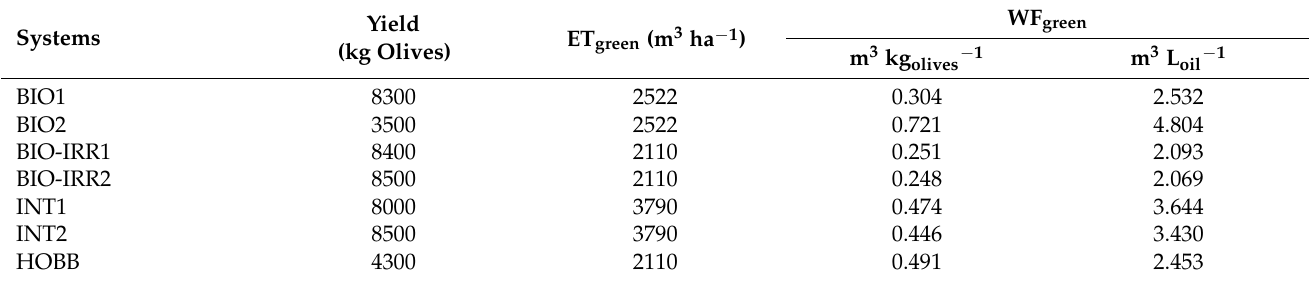
Table 5. Green Water Footprint (WF green ) of the analyzed systems (ET green : evapotranspiration).